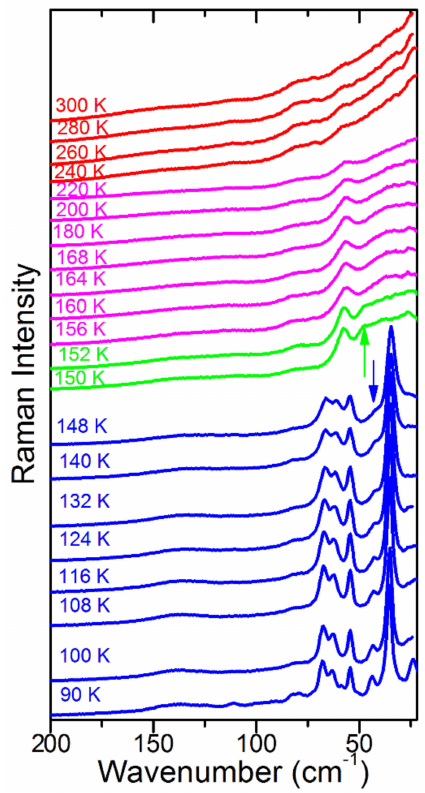
Figure 2. Temperature-dependent Raman spectra in the 200–22 cm − 1 range. Red, magenta, green and blue colours correspond to the Pm 3 m , I 4/ mcm , P 4/ mmm (or Imma ) and Pnma phases, respectively. Green and blue arrows indicate bands, which appear in the low-temperature phases at about 47 and 43 cm − 1 ,